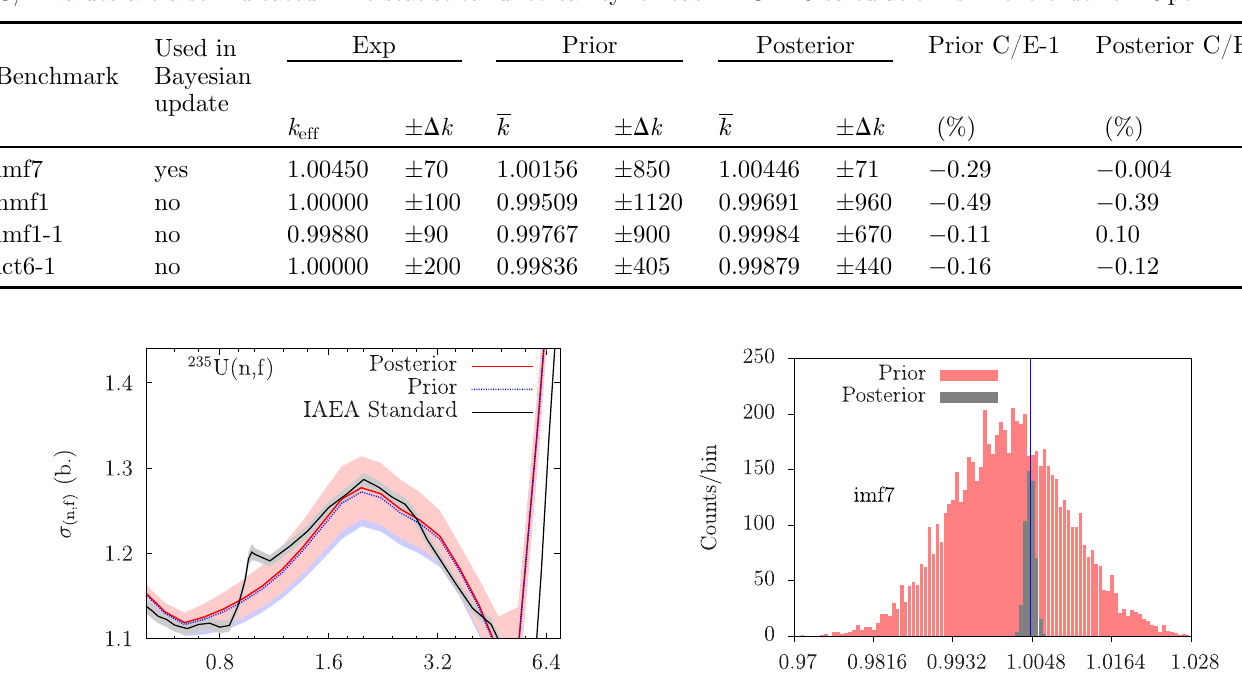
and uncertainties for four benchmarks. Uncertainties D k are given in pcm. eff